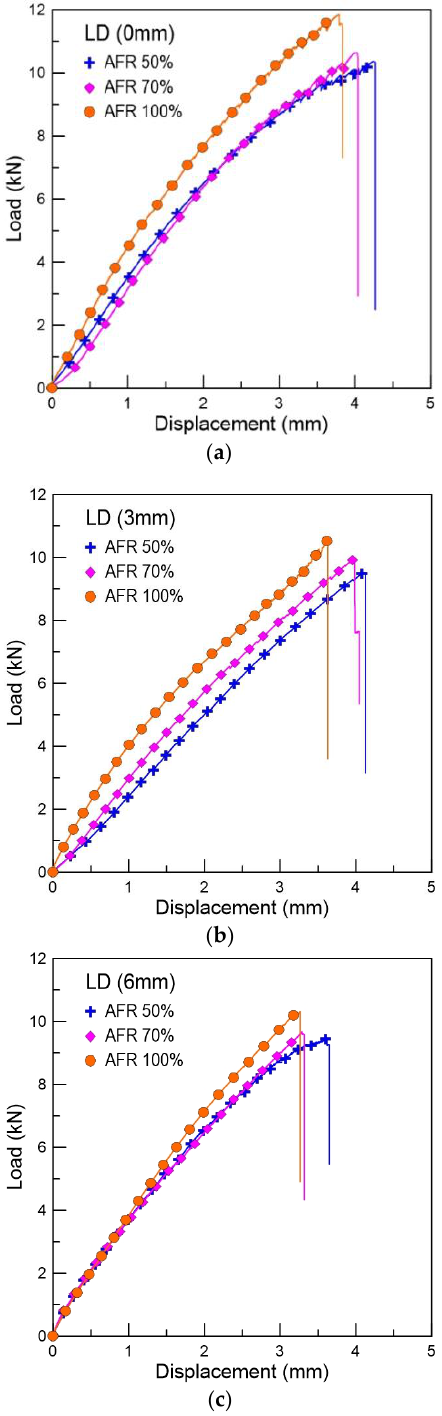
Figure 9. Tensile load and displacement curves of specimens with various level differences : ( a ) 0 mm, ( b ) 3 mm, and ( c ) 6 mm.